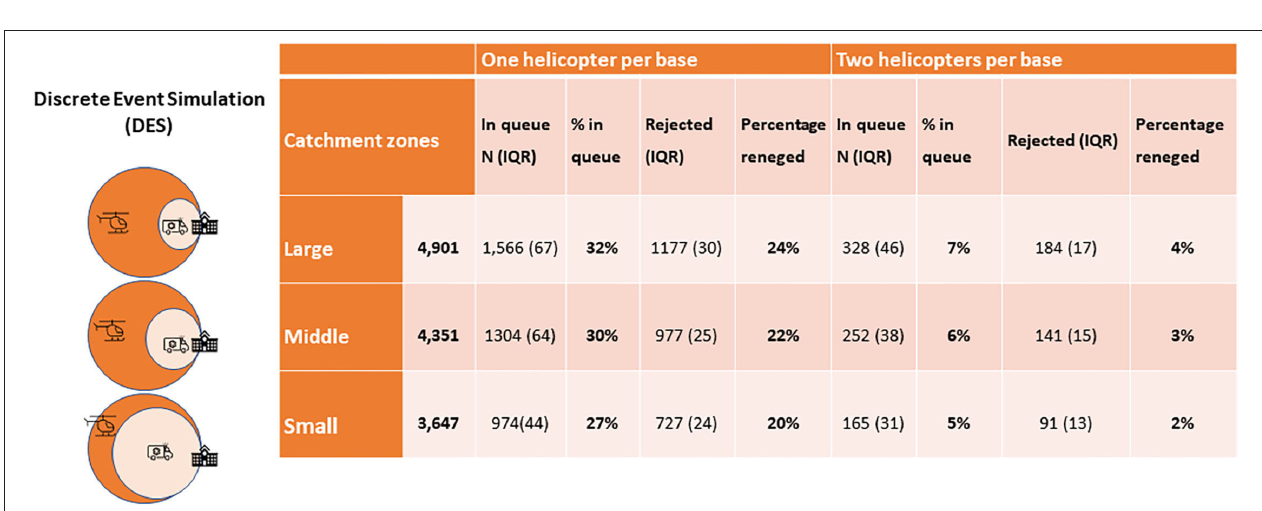
FIGURE 3 | Helicopter flights per municipality as functions of ground transport time, total estimated helicopter time, and the difference between ground transport and helicopter transport times. The municipalities with the highest numbers of citizens are close to the CSCs, but there is a trend toward a high incidence of strokes far away from the CSCs.